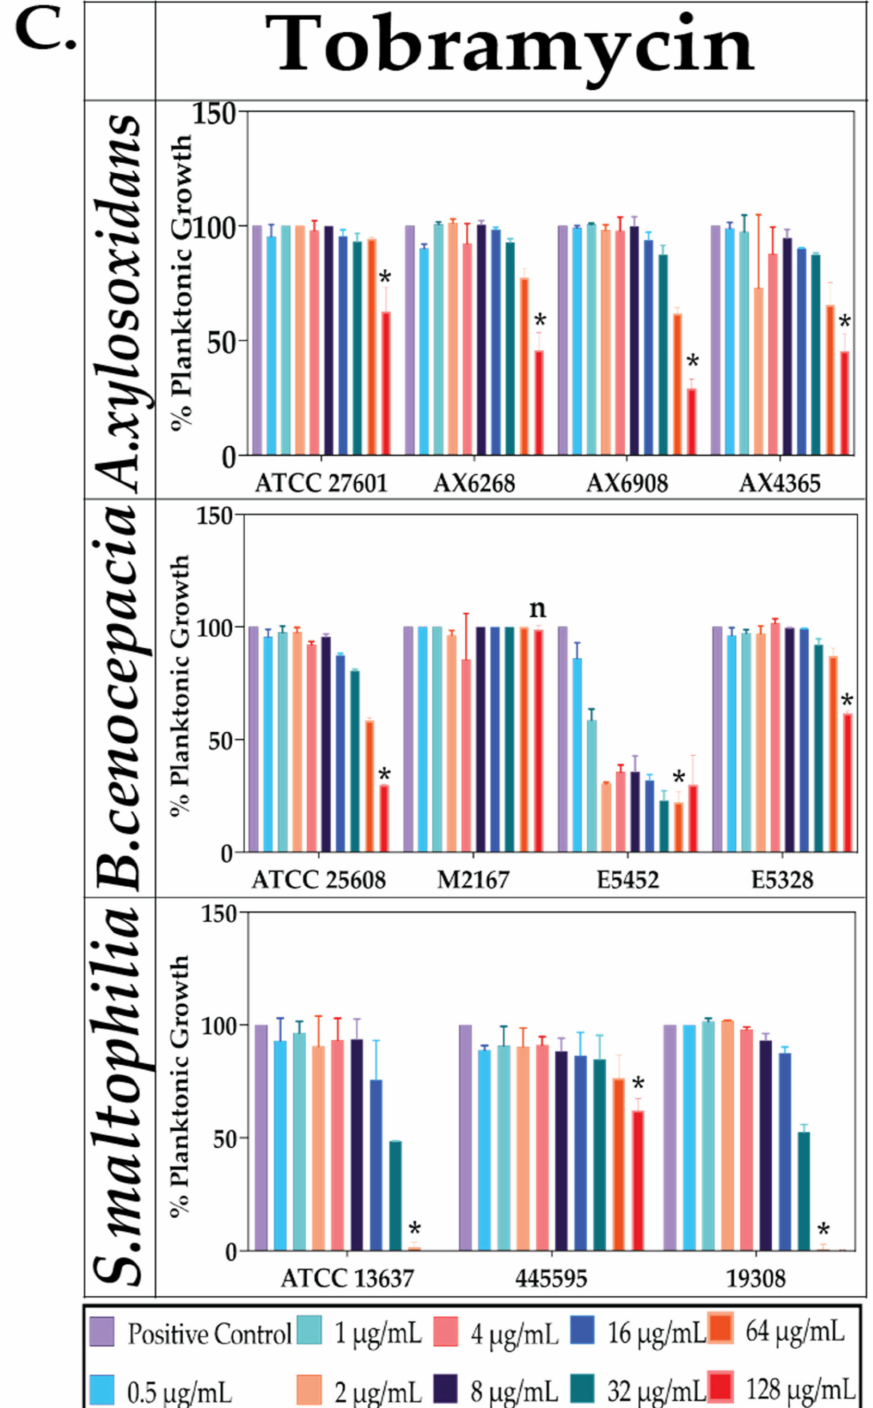
Figure 2. The effect of antibiotics alone on planktonic bacterial growth. Concentration-dependent effect of the antibiotics ( A ) ciprofloxacin, ( B ) colistin and ( C ) tobramycin on percentage planktonic growth of B. cenocepacia, A. xylosoxidans and, S. maltophilia strains. Statistical analyses were performed using unpaired Student’s t -tests (with Welch’s correction) and multiple comparison tests (Kruskal–Wallis test with Dunn’s correction). Significance cut-offs are as follows p > 0.05 ( n ), p ≤ 0.05 ( * ). Data represent an average of n = 3 biological